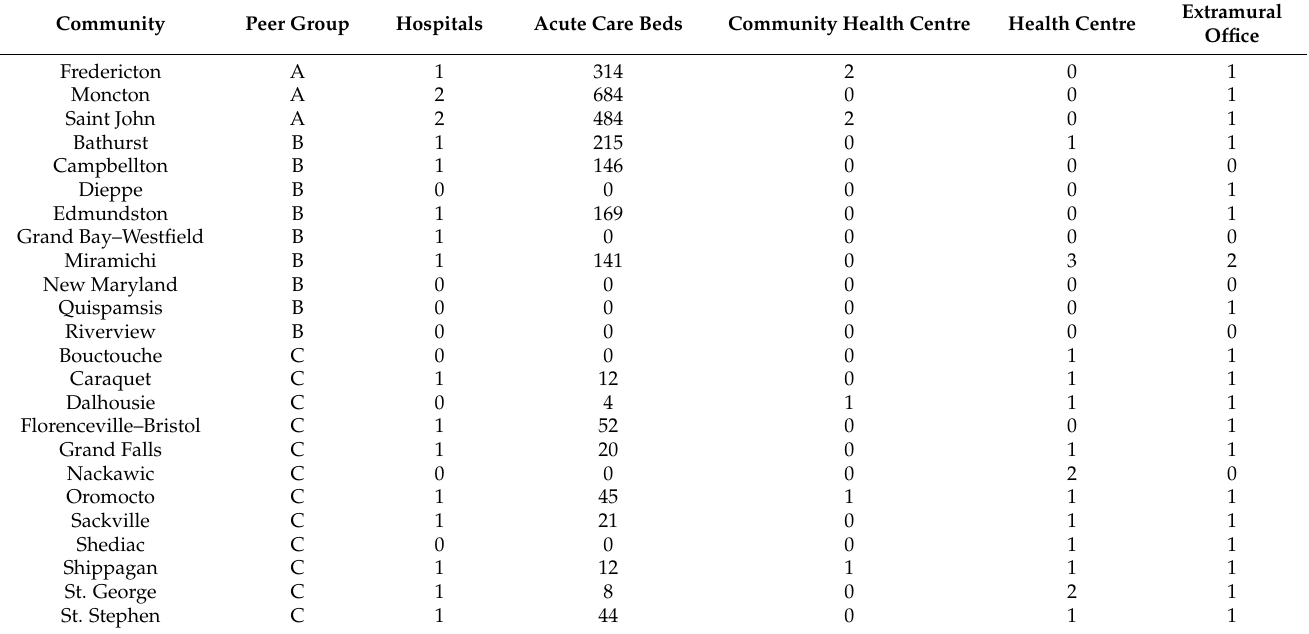
Table 1. Provision of acute and primary care services per the Health Council Community (HCC) as of